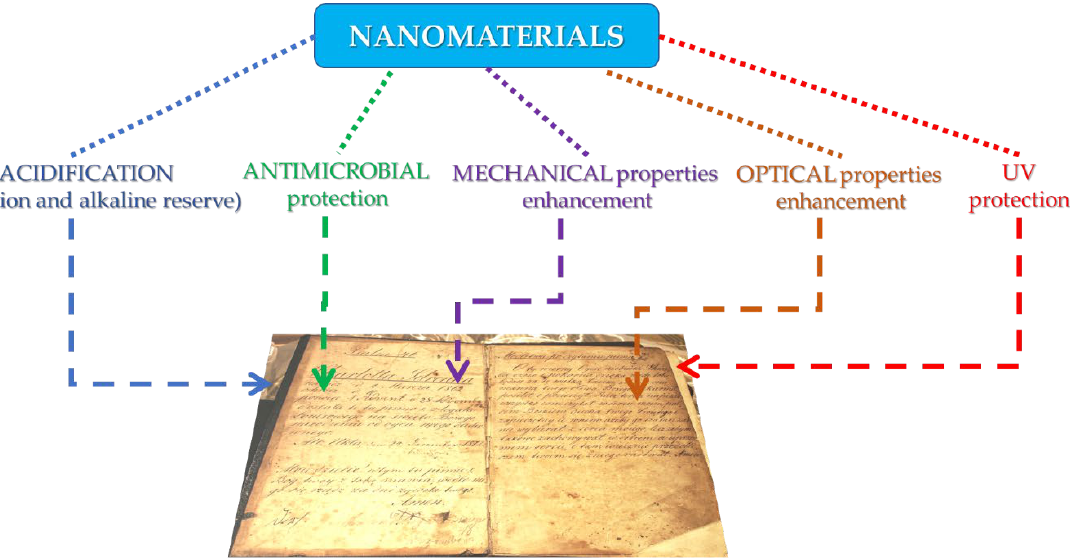
Figure 3. Application of nanomaterials for the protection of paper